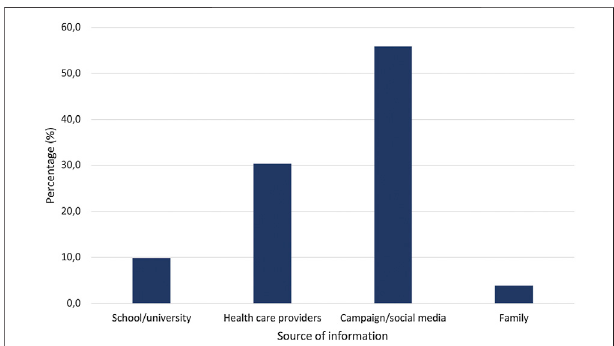
FIGURE 1 | Source of information about medication disposal